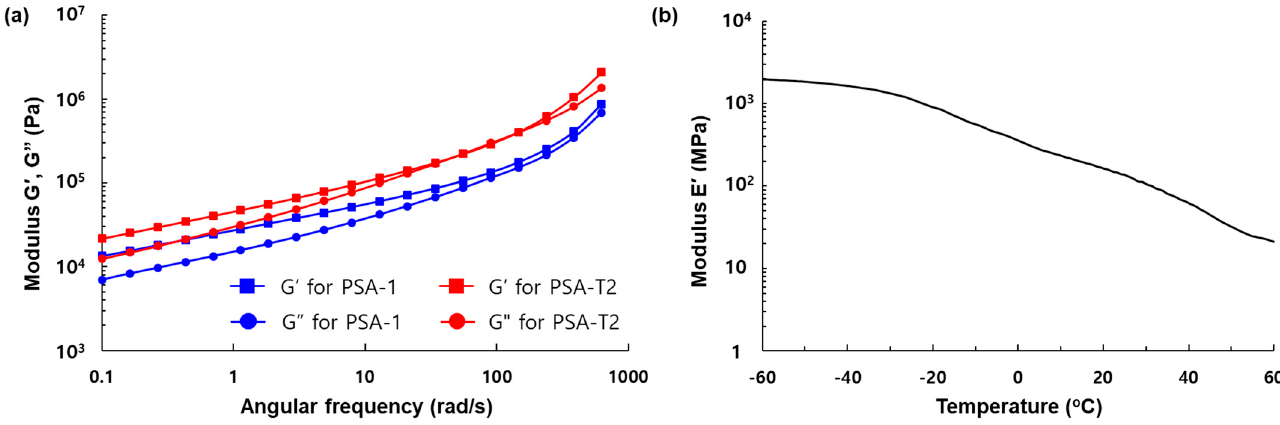
Figure 3. ( a ) G (cid:48) , G” against the angular frequency for PSA-1 and PSA-T2 measured by a rheometer; ( b ) E (cid:48) versus temperature Figure 3. ( a ) G ′ , G ″ against the angular frequency for PSA − 1 and PSA − T2 measured by a rheometer; ( b ) E ′ versus temper- ature of the cure PSA − U3. of the cure